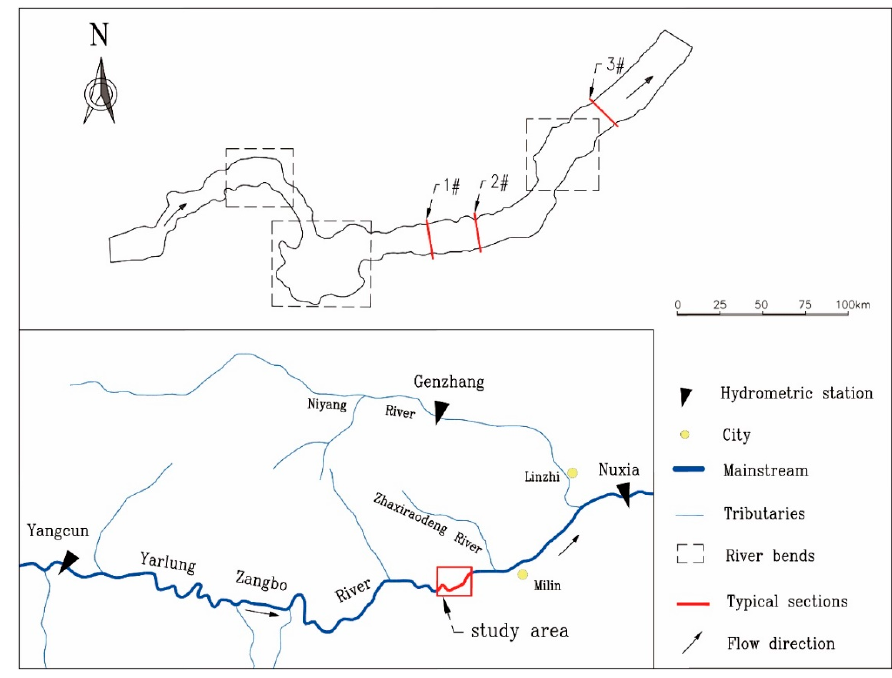
Figure 1. Water system in the study area.